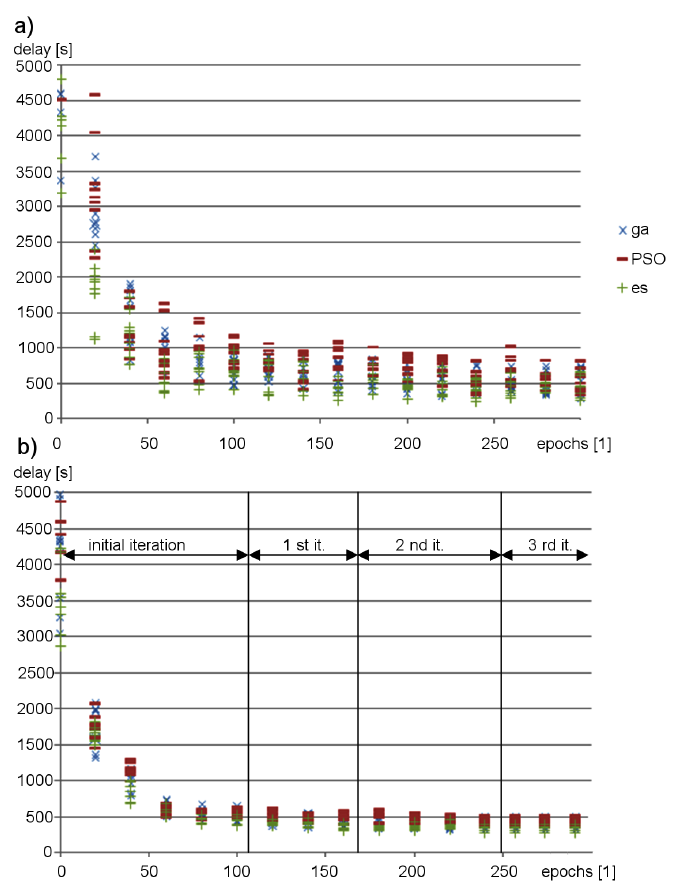
Figure 16. Changes of vehicle delay during optimization procedure: ( a ) ANN_DG; and ( b ) the proposed neural network